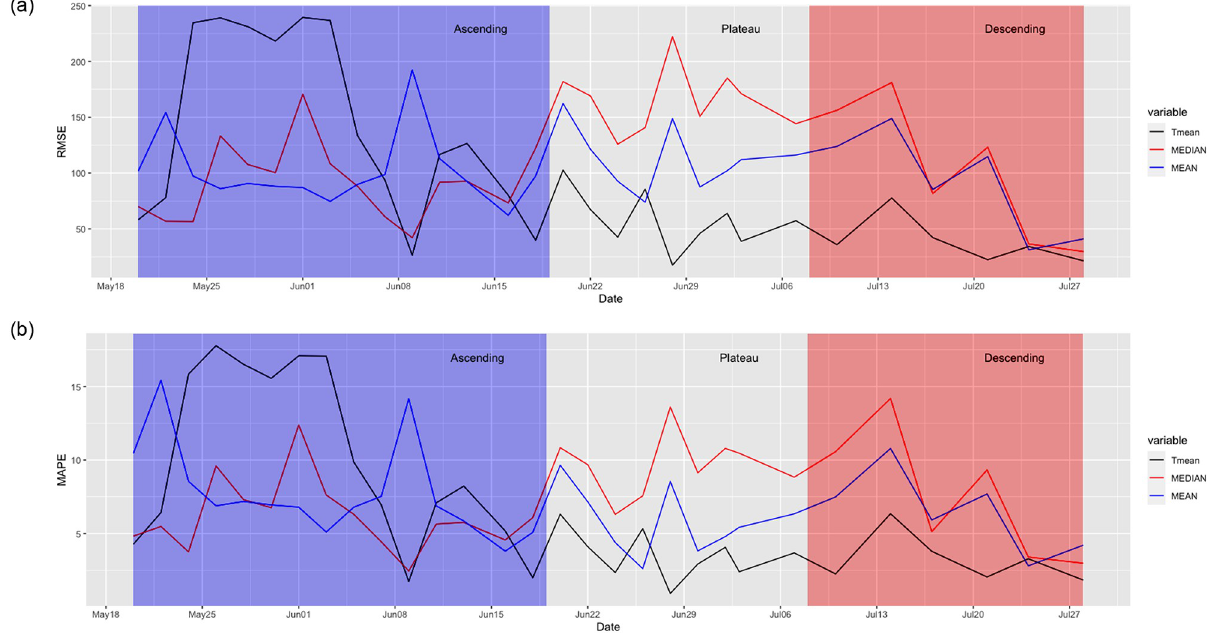
Fig 6. Forecasting errors by ensemble type across iterations. RMSEs are the upper panel and MAPE are in the bottom panel.